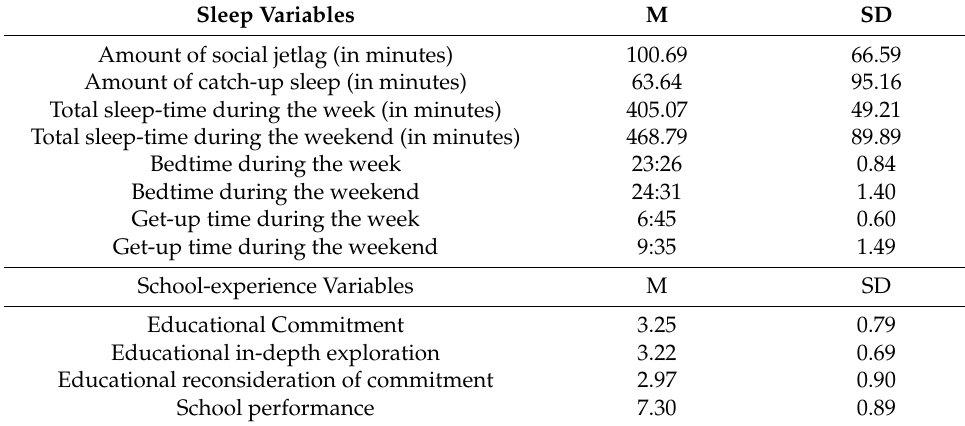
Table 1. Sleep characteristics of the sample. Means (M) and standard deviations (SD) are shown. Sleep Variables M SD Amount of social jetlag (in minutes) 100.69 66.59 Amount of catch-up sleep (in minutes) 63.64 95.16 Total sleep-time during the week (in minutes) 405.07 49.21 Total sleep-time during the weekend (in minutes) 468.79 89.89 Bedtime during the week 23:26 0.84